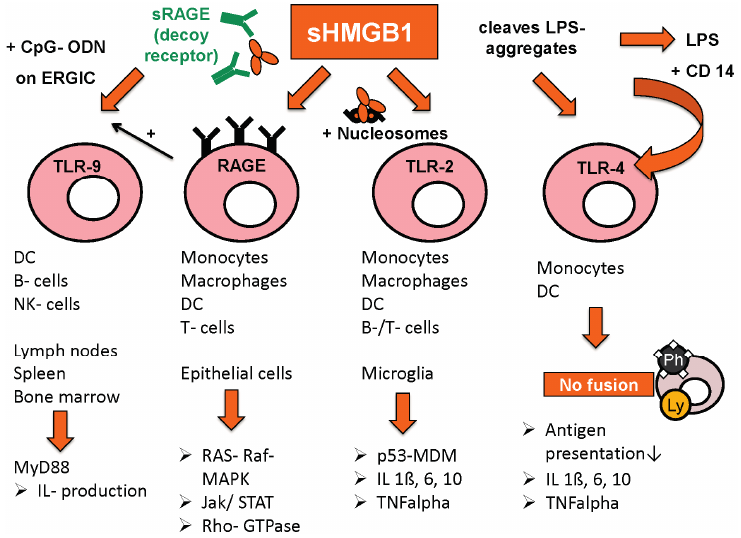
Figure 3. Receptors for HMGB1 and following pathways (adapted from [103] with permission from De